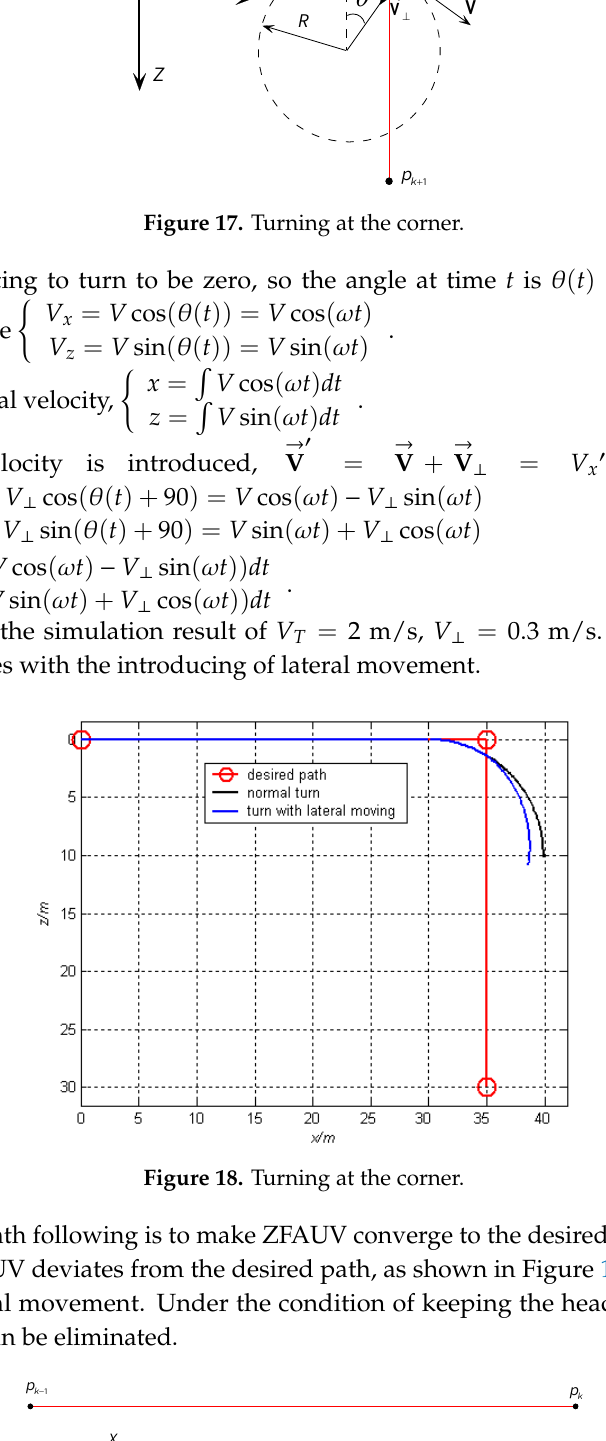
( b ) simulation heading Figure 20. Comparison of different following strategies when deviation occurs. Therefore, the simpler path following strategy integrating basic LOS and lateral movement is adopted in this paper, as shown in Figure 11, where, the cross-track error and the heading error are the key factors. The nature is to make the cross-track error and the heading error tend to be zero, and ZFAUV moves along with the desired path continuously.